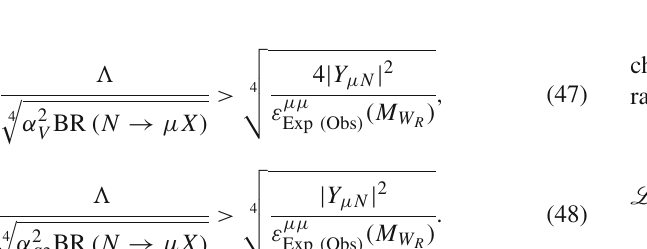
(cid:15) α 2 BR in NEFT V